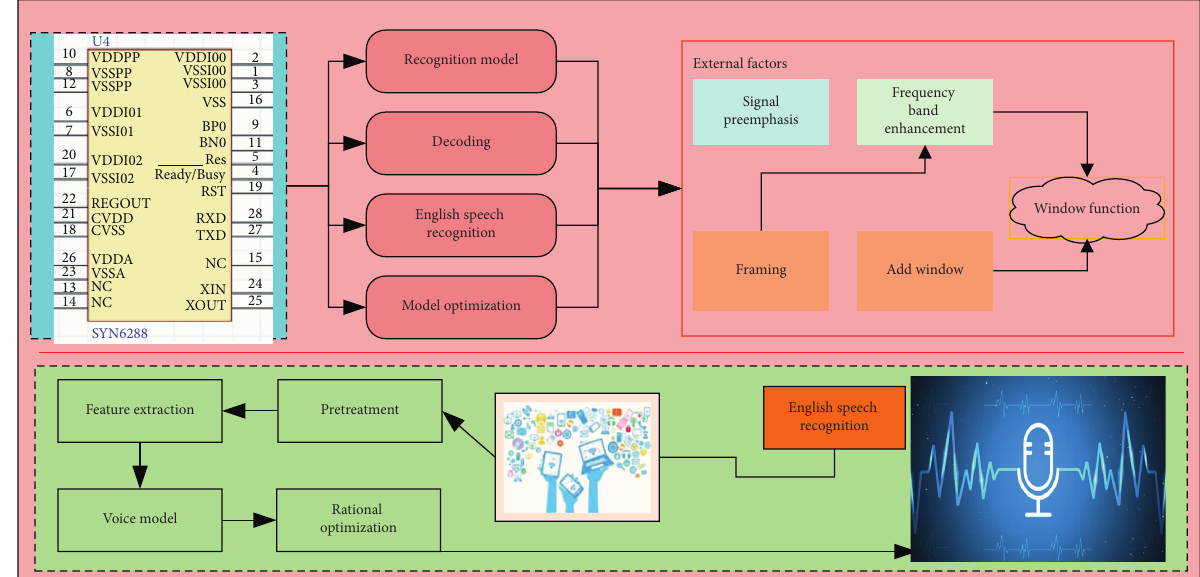
Figure 1: English speech rationality optimization recognition